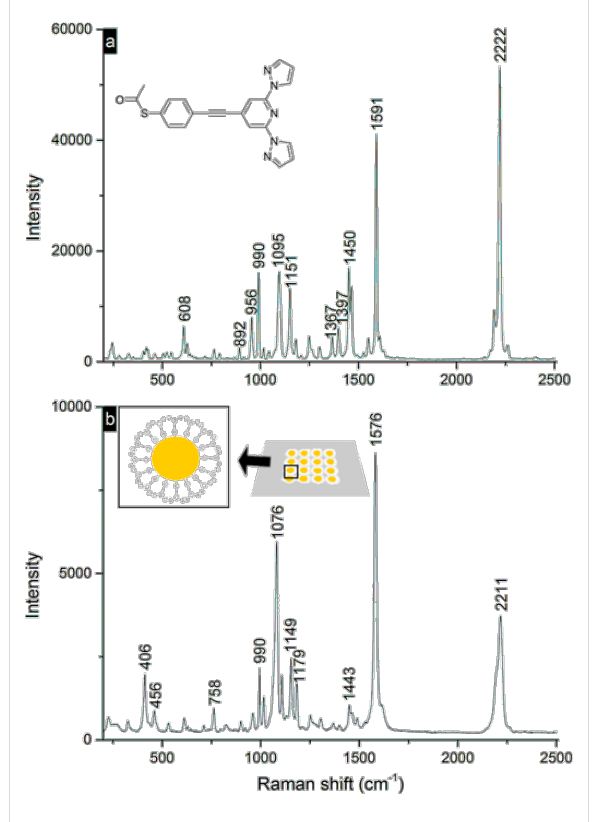
Figure 3: a) Room temperature Raman spectrum of bulk (powder) SAc-BPP molecules showing the region of 200–2400 cm − 1 excited at 633 nm (1.2 mW illuminating power on the sample); b) Room tempera- ture Raman spectrum of 2D (single layer) Au-NP–S-BPP array obtained by microcontact printing on a quartz